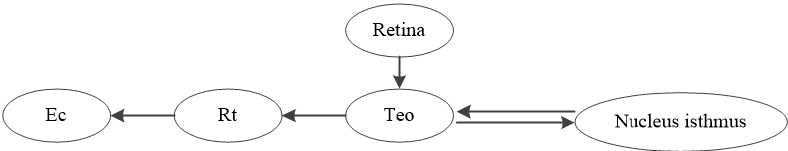
Figure 8. The schematic diagram of the optic tectum